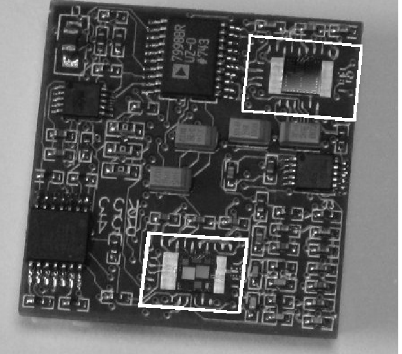
Figure 19. Topmost component of the Tyndall25 mote with two MEMS multisensor bare